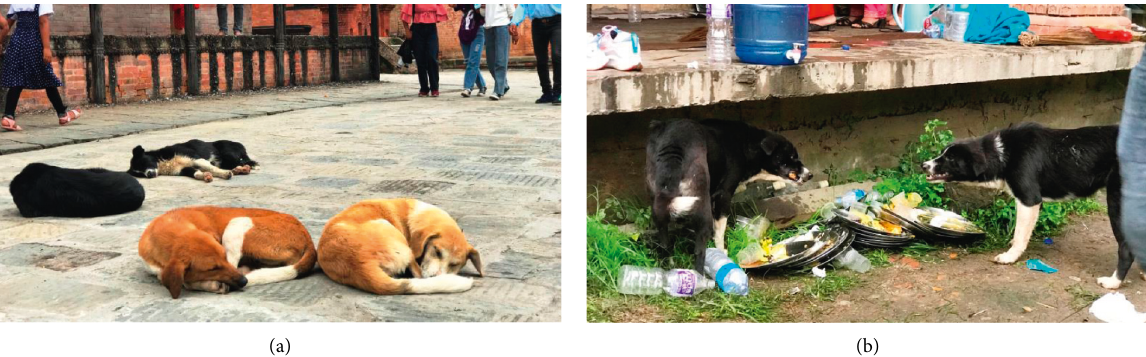
Figure 2: (a, b) Close interface between dogs and humans (photos kindly provided by Dikpal Karmacharya, Third Pole Conservancy, Bhaktapur, Nepal). The photographs represent the common situation of human-domestic animal existence